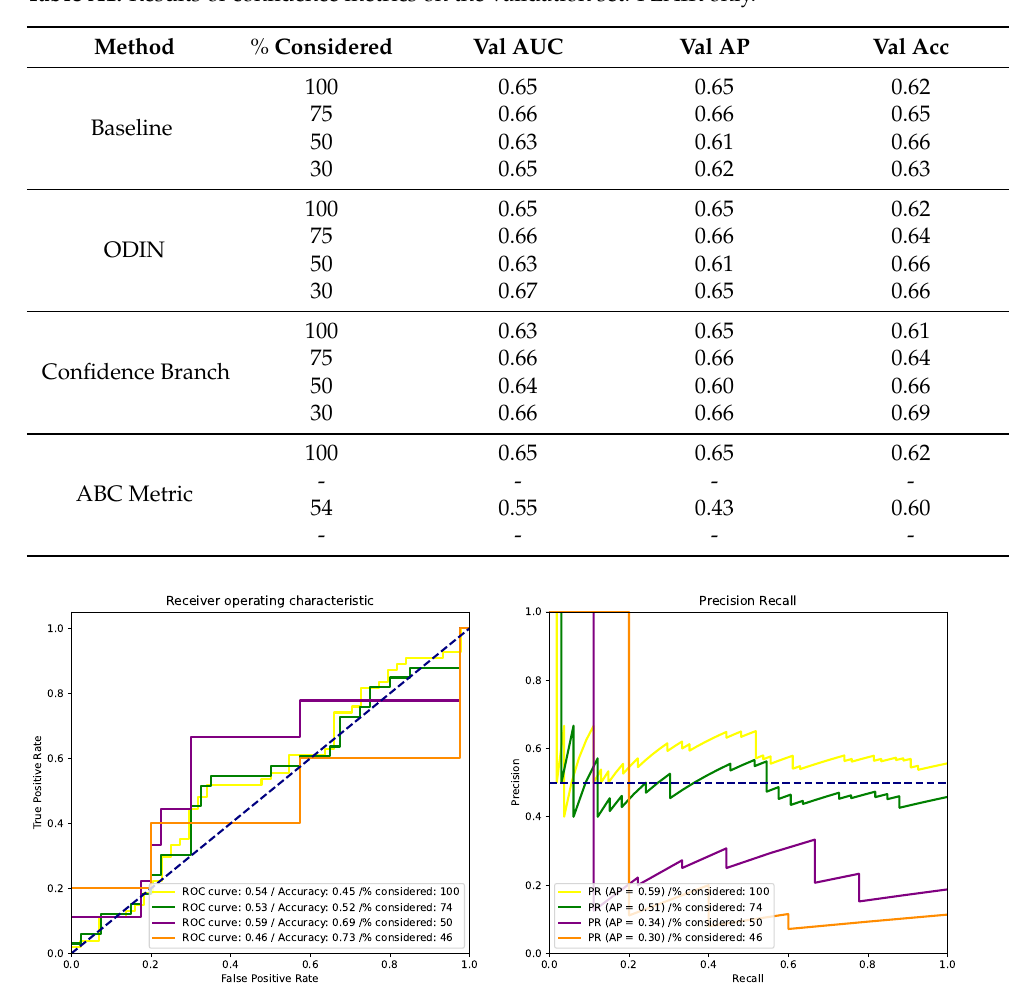
Table A1. Results of confidence metrics on the validation set. FLAIR only.